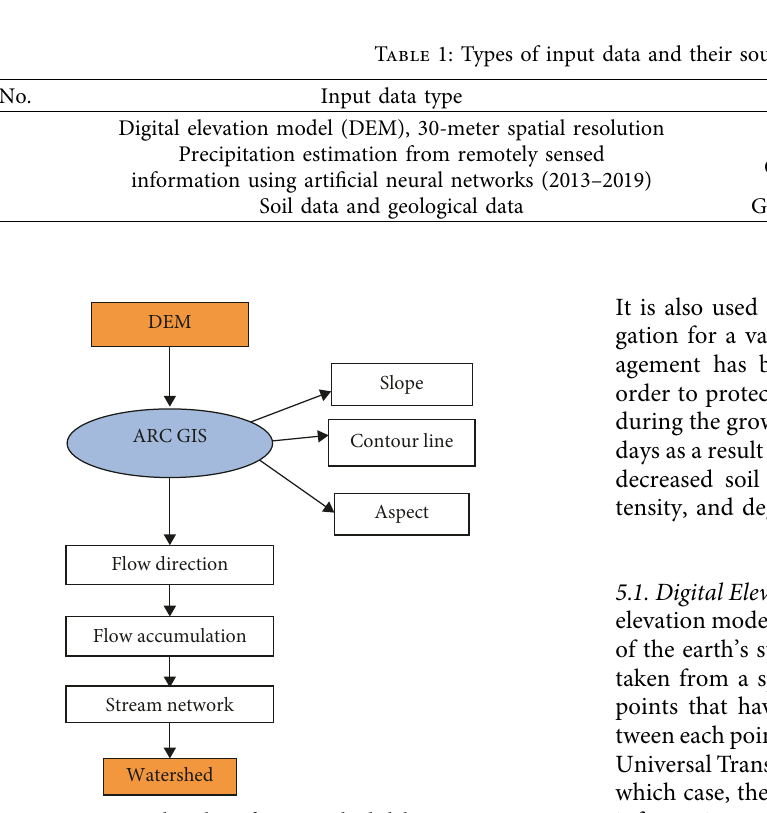
Figure 2: Flowchart for watershed